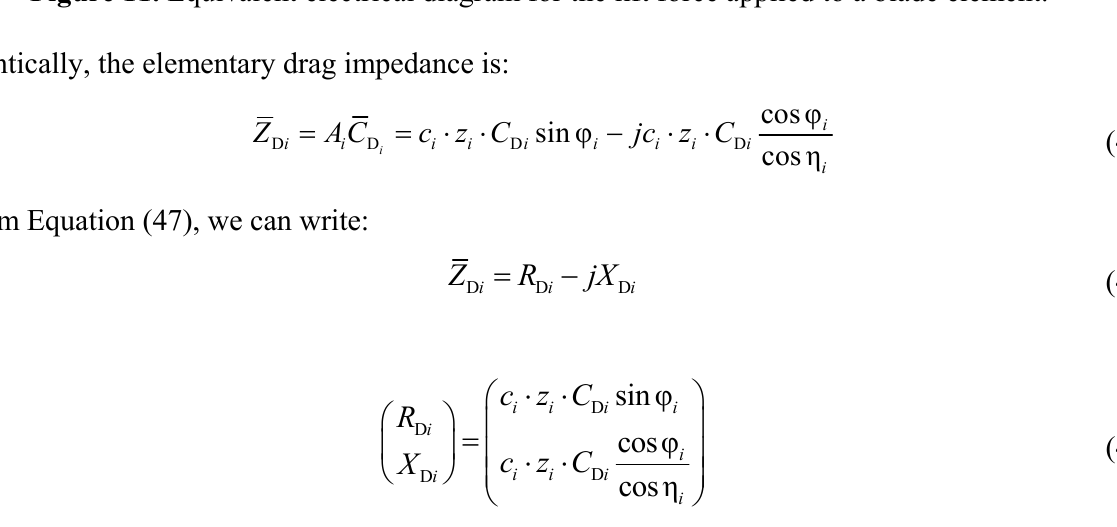
Figure 11. Equivalent electrical diagram for the lift force applied to a blade element.